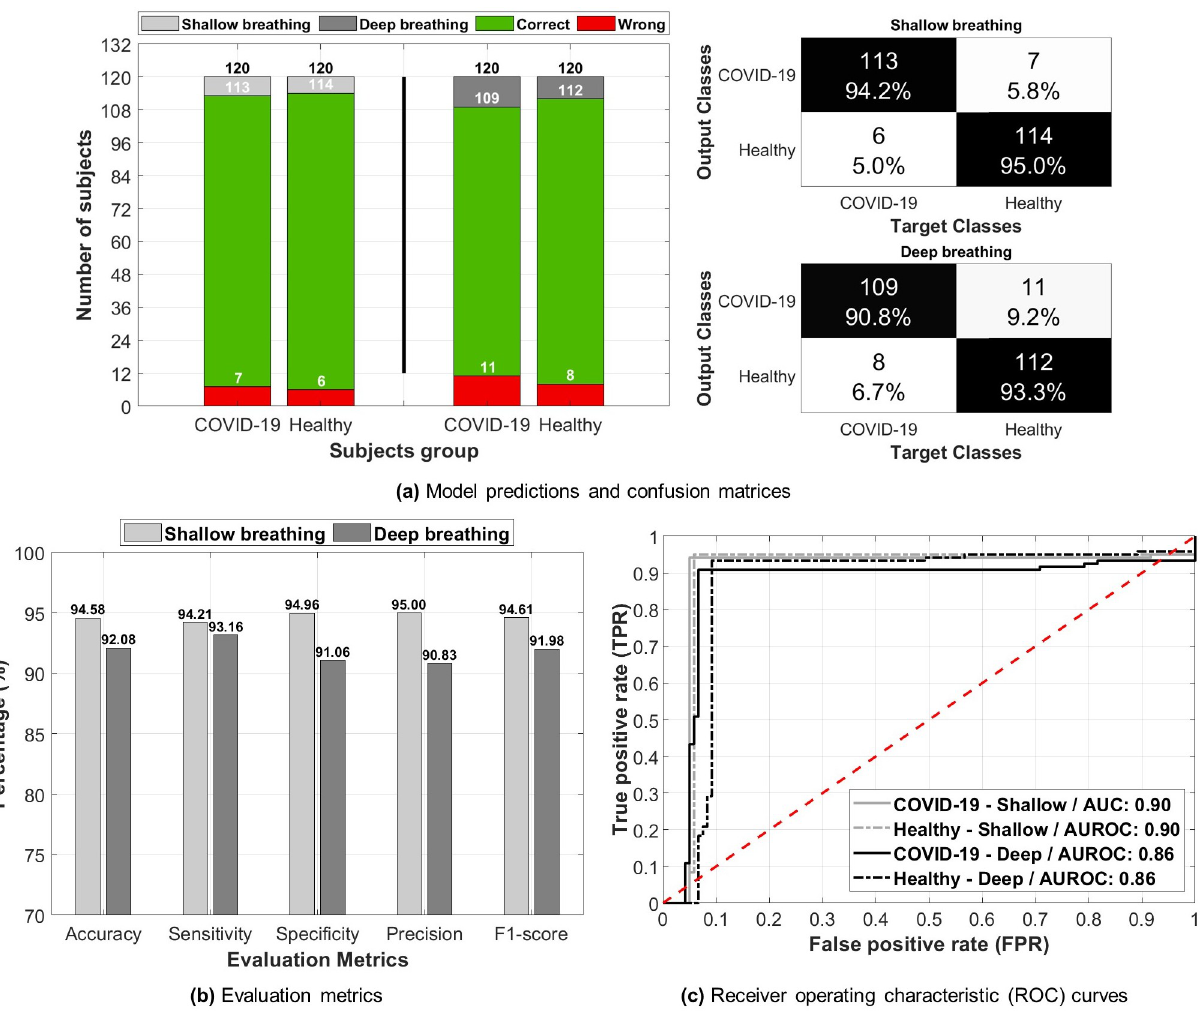
Fig 7. The performance of the deep learning model in predicting COVID-19 and healthy subjects using shallow and deep breathing datasets. Showing: (a) model’s predictions for both datasets and he corresponding confusion matrices, (b) evaluation metrics including accuracy, sensitivity, specificity, precision, and F1-score, (c) receiver operating characteristic (ROC) curves and corresponding area under the curve (AUROC) for COVID-19 and healthy subjects using both datasets.